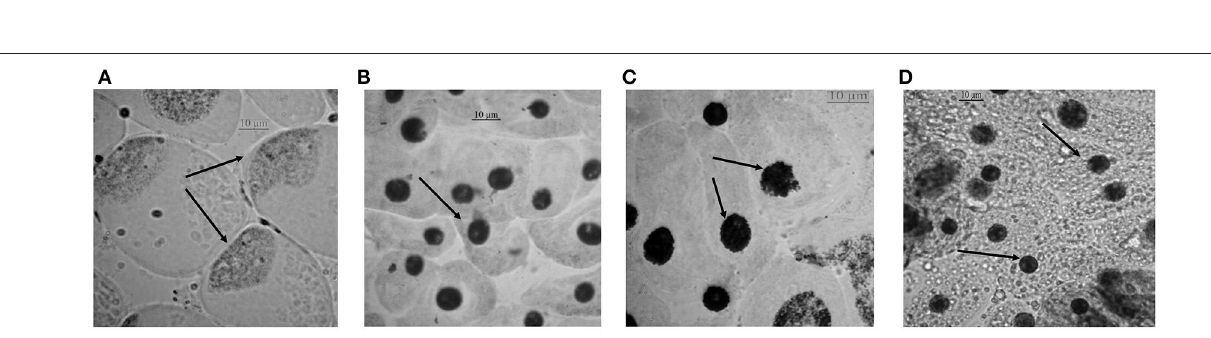
FIGURE 6 | Incidence of various aberrations on NiO-NP exposure (for Anova analysis, consult S.I).